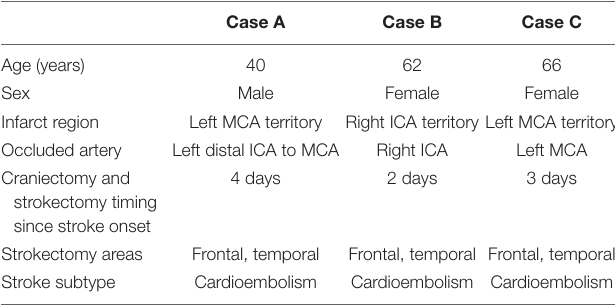
TABLE 2 | Clinical information of the human stroke